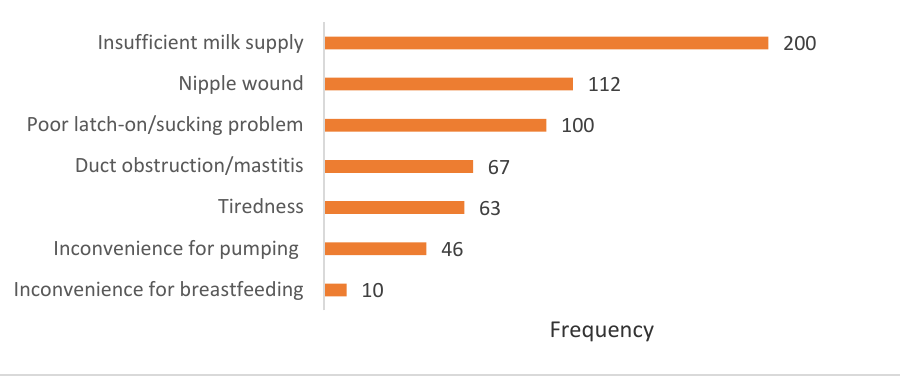
Figure 5. Six-month exclusive breastfeeding survival analysis (months) . When comparing the duration of EBF practice by log rank test, we found that the median EBF duration in the following participant groups was significantly shorter than their counterparts; that is, at a younger age, lower education level, no experiences of achieving 6-month EBF practice in the previous child, and intention during pregnancy to breastfeed for a shorter duration (with p varying between 0.001 and 0.05), as shown in Table 2. Table 2. Period of exclusive breastfeeding (EBF) survival by personal attributes (log rank) . Variables